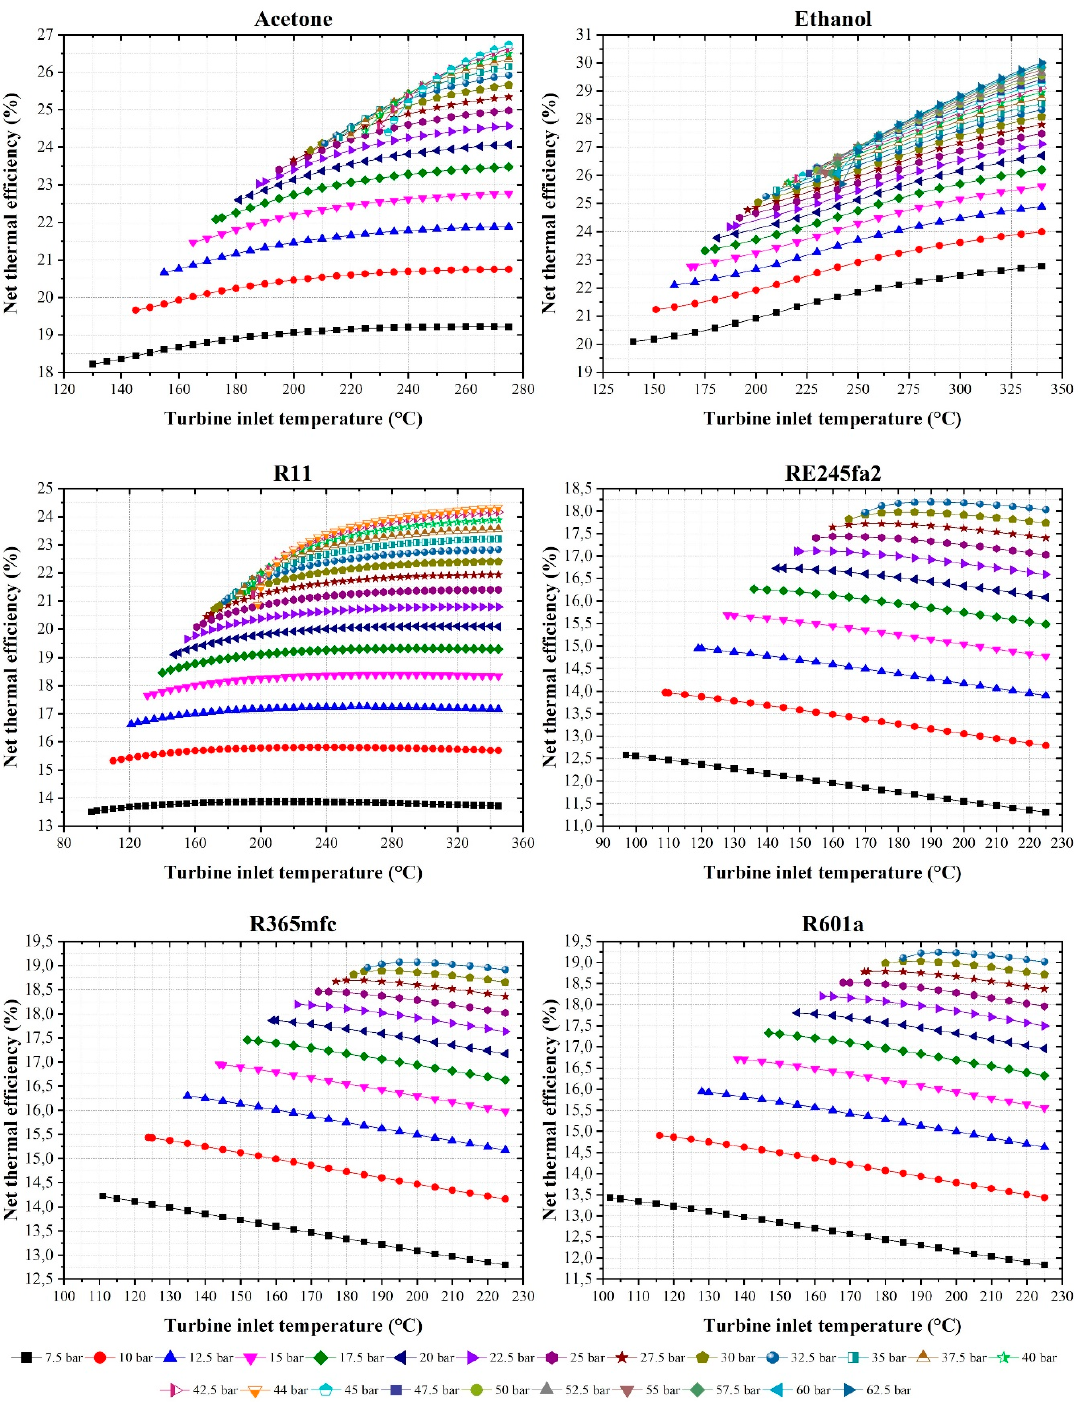
Figure 7. The net thermal efficiency calculated from the ORC for varying turbine inlet temperatures and turbine inlet pressures.